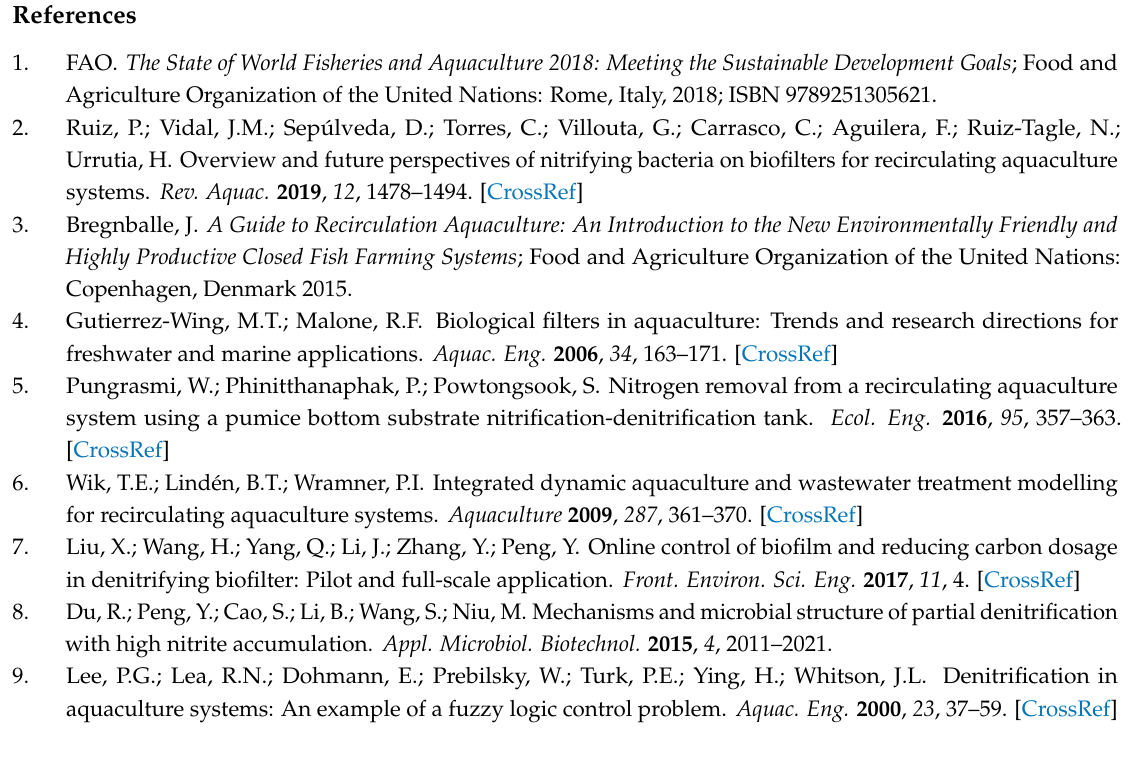
Table S1: Stoichiometry for carbon oxidation, nitrification, and denitrification; Table S2: Process kinetics for carbon oxidation, nitrication, and